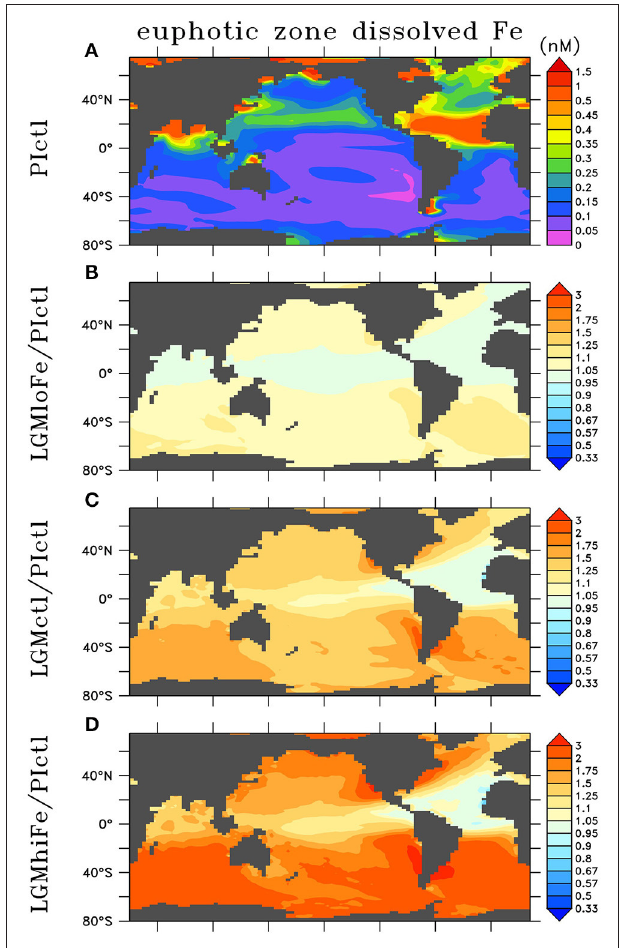
FIGURE 3 | Annual euphotic zone dissolved iron in (A) preindustrial control (PIctl) and the ratio relative to preindustrial of the LGM simulations (B) LGMloFe, (C) LGMctl, and (D) LGMhiFe based on LGM atmospheric deposition estimates (Albani et al.,